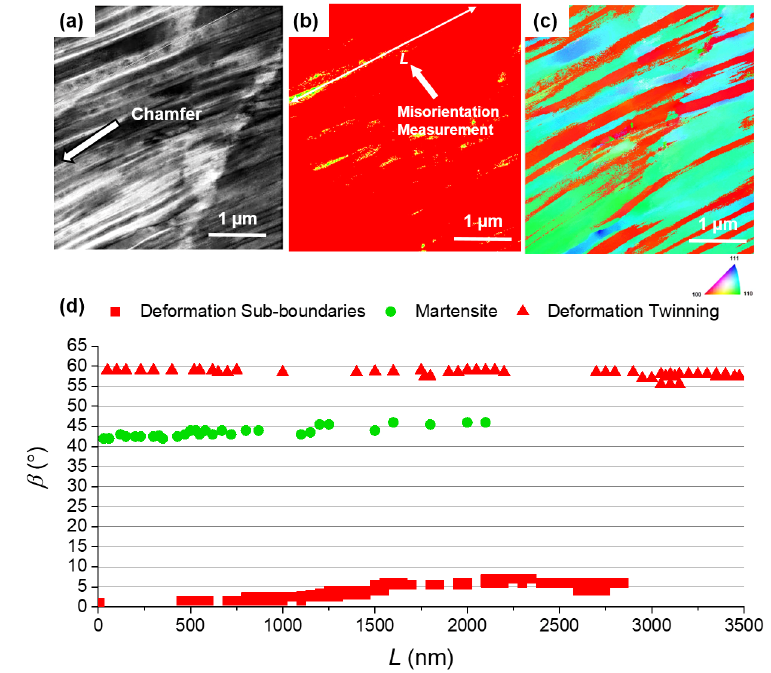
Figure 8. ASTAR orientation analysis and phase-mapping, verifying transformation from austenite to martensite in the chamfer zone of as-machined FT1. ( a ) Correlation-index map. ( b ) Phase map. ( c ) Orientation map. ( d ) Misorientation as a function of the spatial coordinate l along the straight line shown in ( b